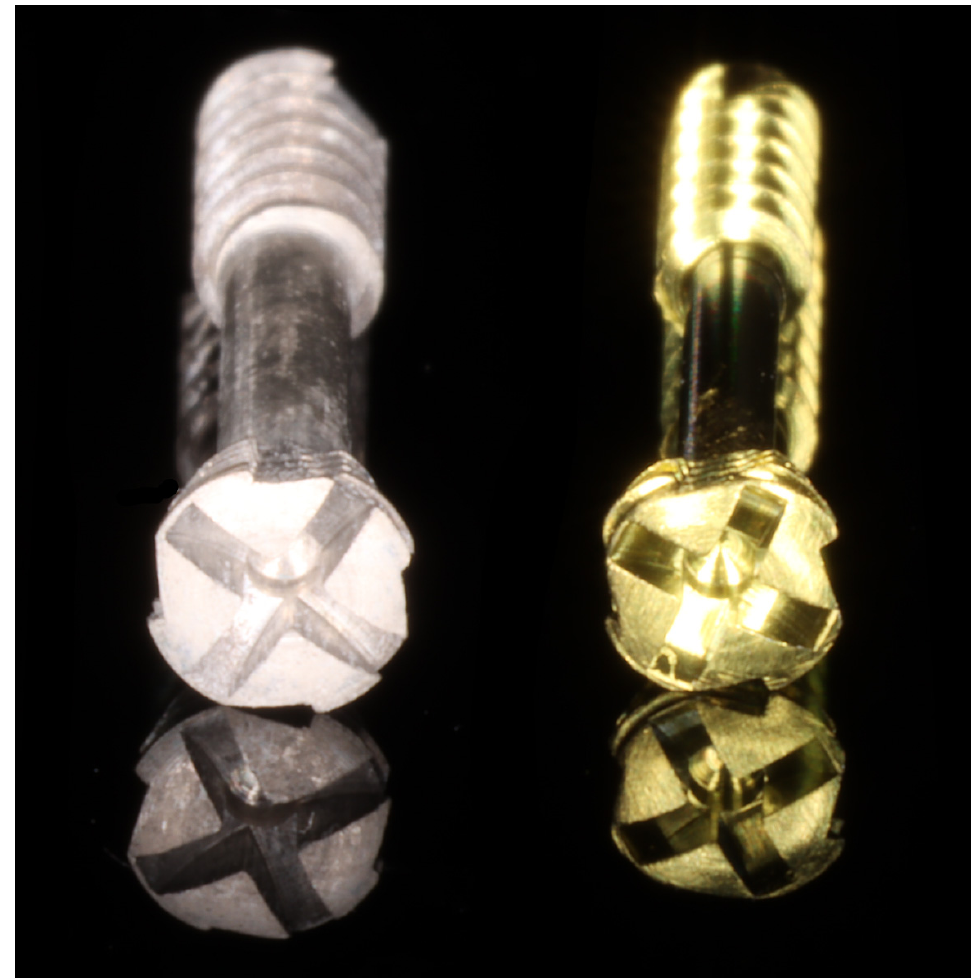
Figure 2. The compression screws used have cross sockets and peripheral notches to collect bone chips. It is assumed that both screw types will be immersed in the bone in their entirety.